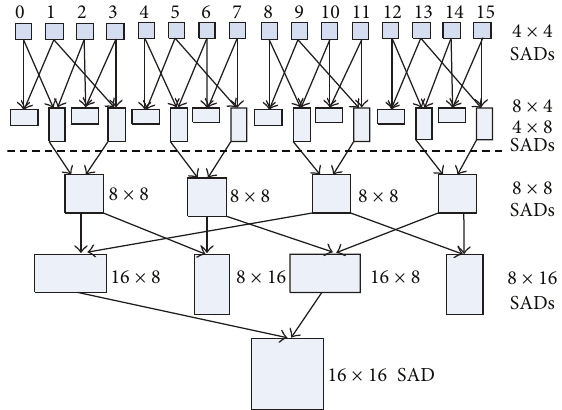
Figure 6: The merging of SAD values for different block.